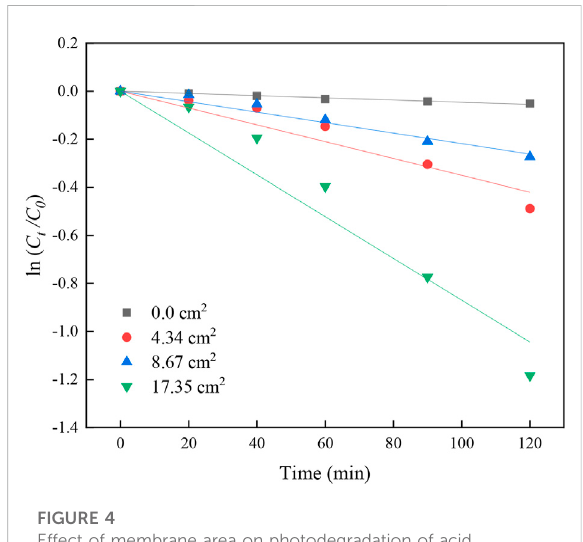
FIGURE 4 Effect of membrane area on photodegradation of acid orange 8 by